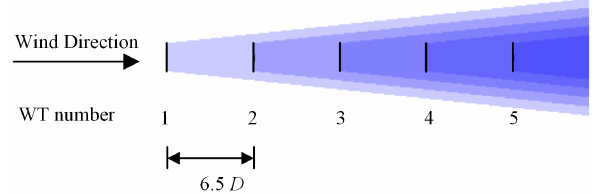
Figure 5. Wind farm